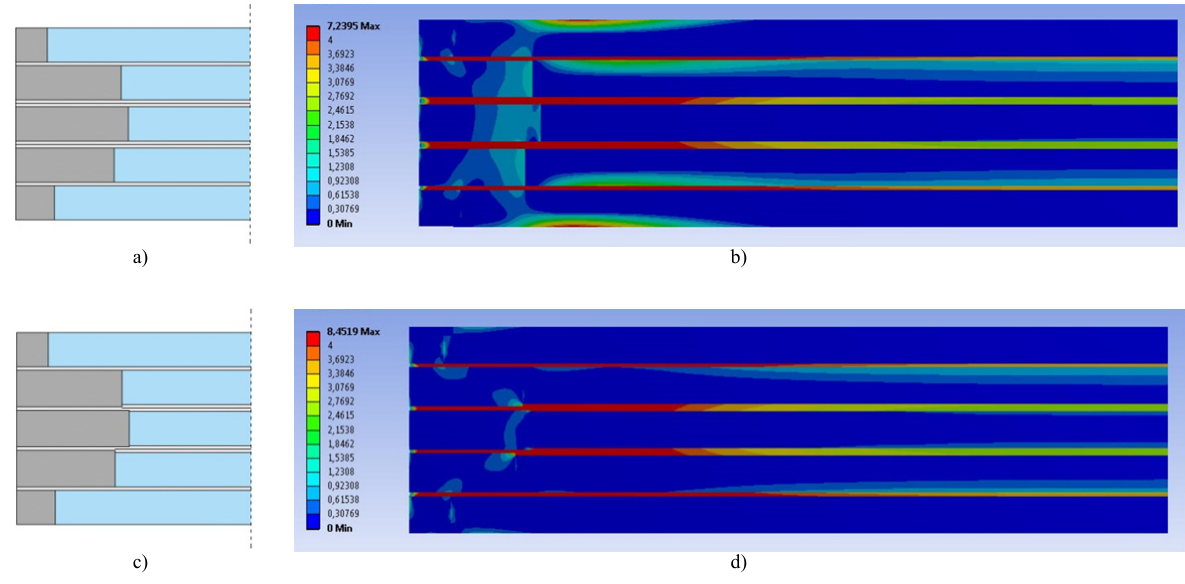
Fig. 3 Maximum principle stress [MPa] caused by thermal contraction after lamination, for two different profiles.